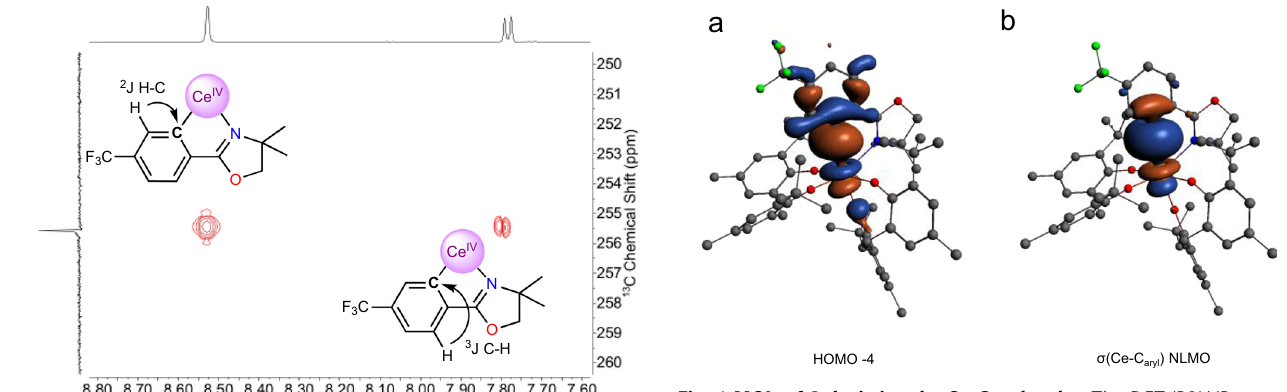
Fig. 6 MO ’ s of 3 depicting the Ce – C aryl bond. a The DFT/B3LYP frontier Kohn-Sham molecular orbital of 3 (HOMO − 4). b The two- center two-electron bonding NLMO. Atomic orbital contributions of the NLMOs and other bond properties of all the Ce containing bonds are listed in Table 1.